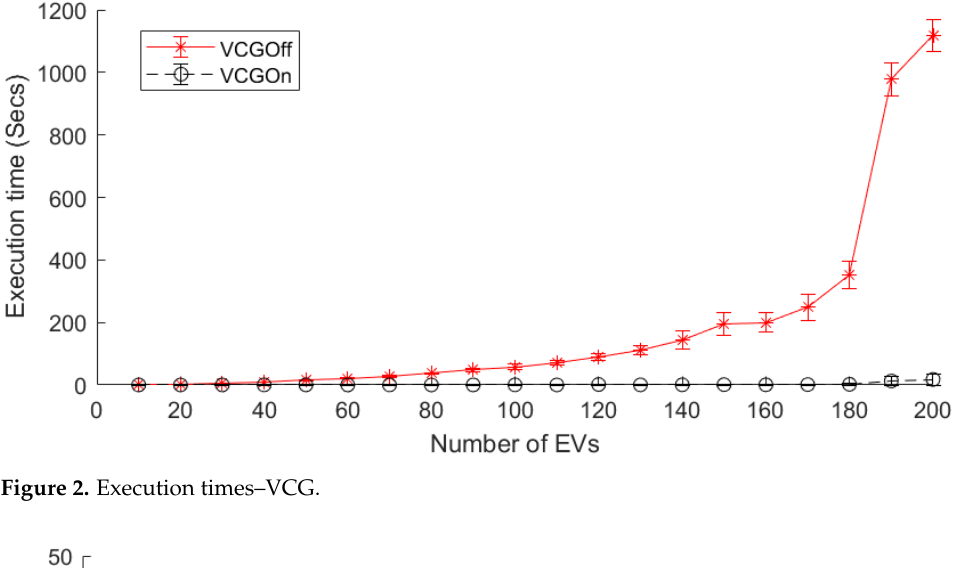
Figure 2. Execution times–VCG.